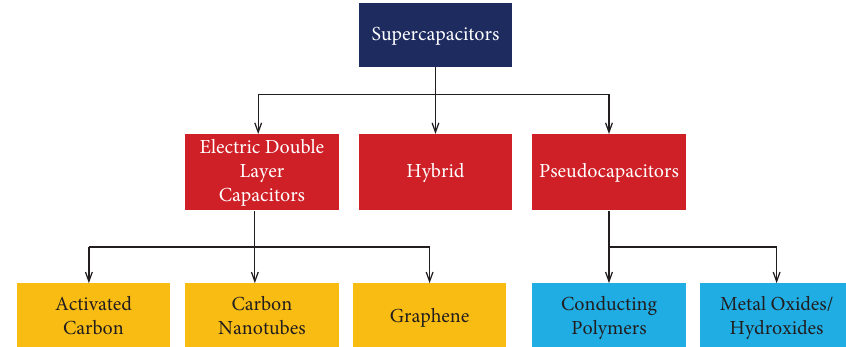
Figure 1: Types of supercapacitors (self-made).